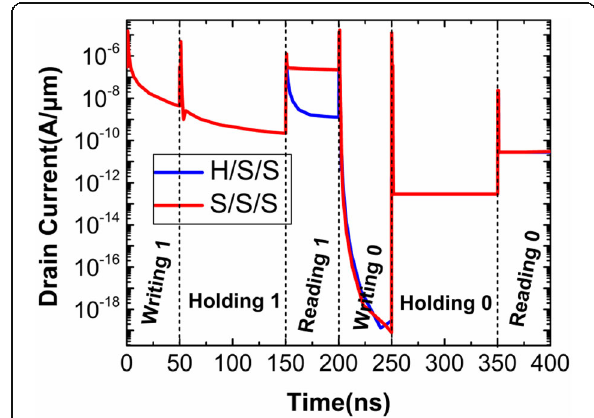
Fig. 4 Transient responses of drain currents for H/S/S and S/S/S